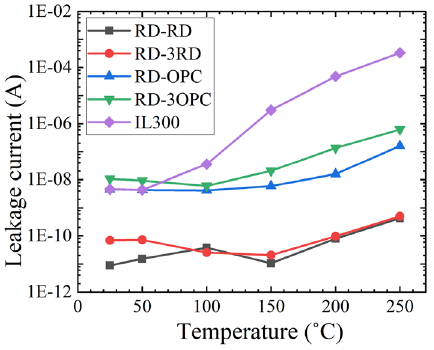
Figure 8. Leakage current of optocouplers with varying temperatures.